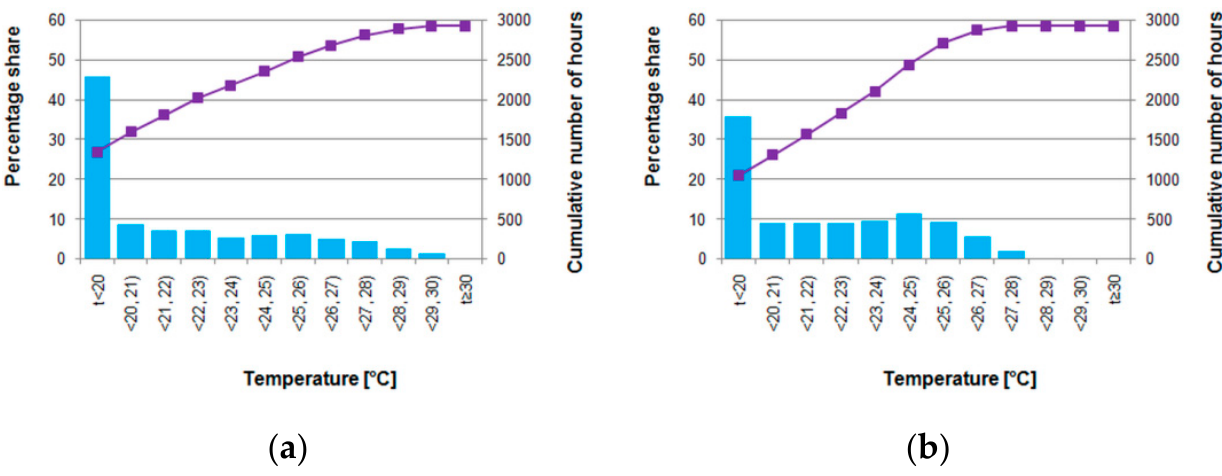
Figure 11. Hourly operative temperature from EnergyPlus and presented model.